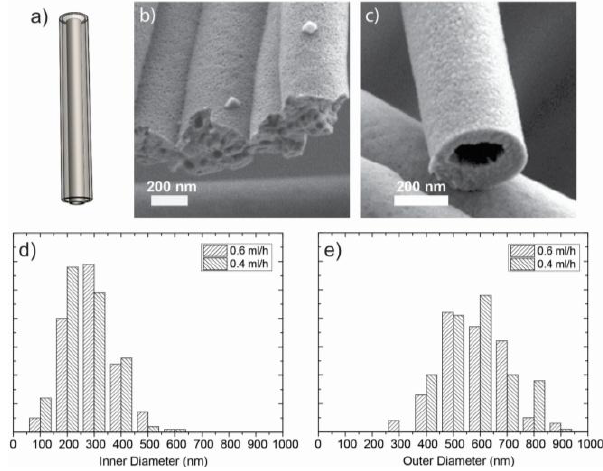
Figure 6. ( a ) Coaxial spinneret; ( b ) coaxial spinning of porous fibers. Inner flow rate is 0.2 mL/h PolyActive solution; Outer flow rate is 1 mL/h of 3YSZ precursor solution; no hollow fibers are formed; ( c ) hollow fiber made by coaxial electrospinning. Inner flow rate is 0.6 mL/h of the PolyActive solution; the outer flow rate rete is 1 mL/h of 3YSZ solution; ( d ) frequency distribution of the inner hollow fiber diameter at inner flow rates of 0.4 and 0.6 mL/h of the PolyActive solution. The outer flow rate is 1 mL/h of 3YSZ precursor solution; and ( e ) frequency distribution of the outer hollow fiber diameter under the same conditions. The fibers shown were thermally treated at 850 °C.